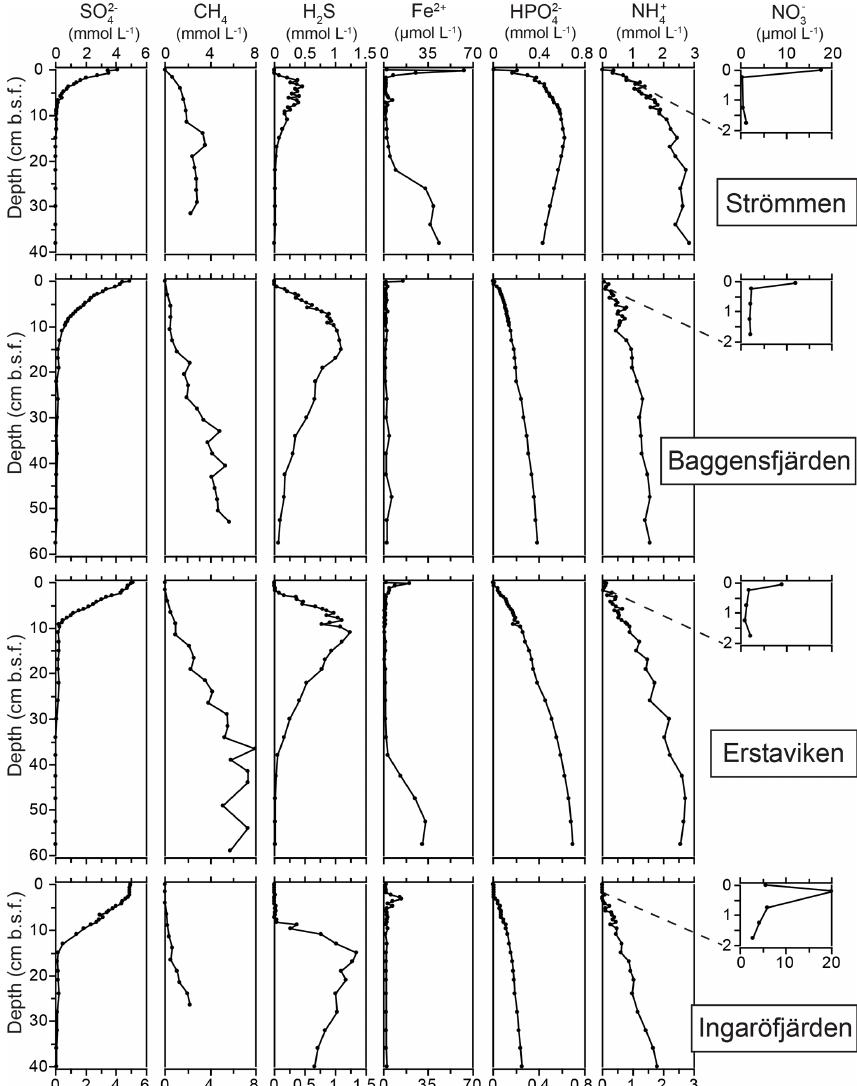
Figure 4. Pore water depth profiles of SO 2 − Baggensfjärden, Erstaviken and